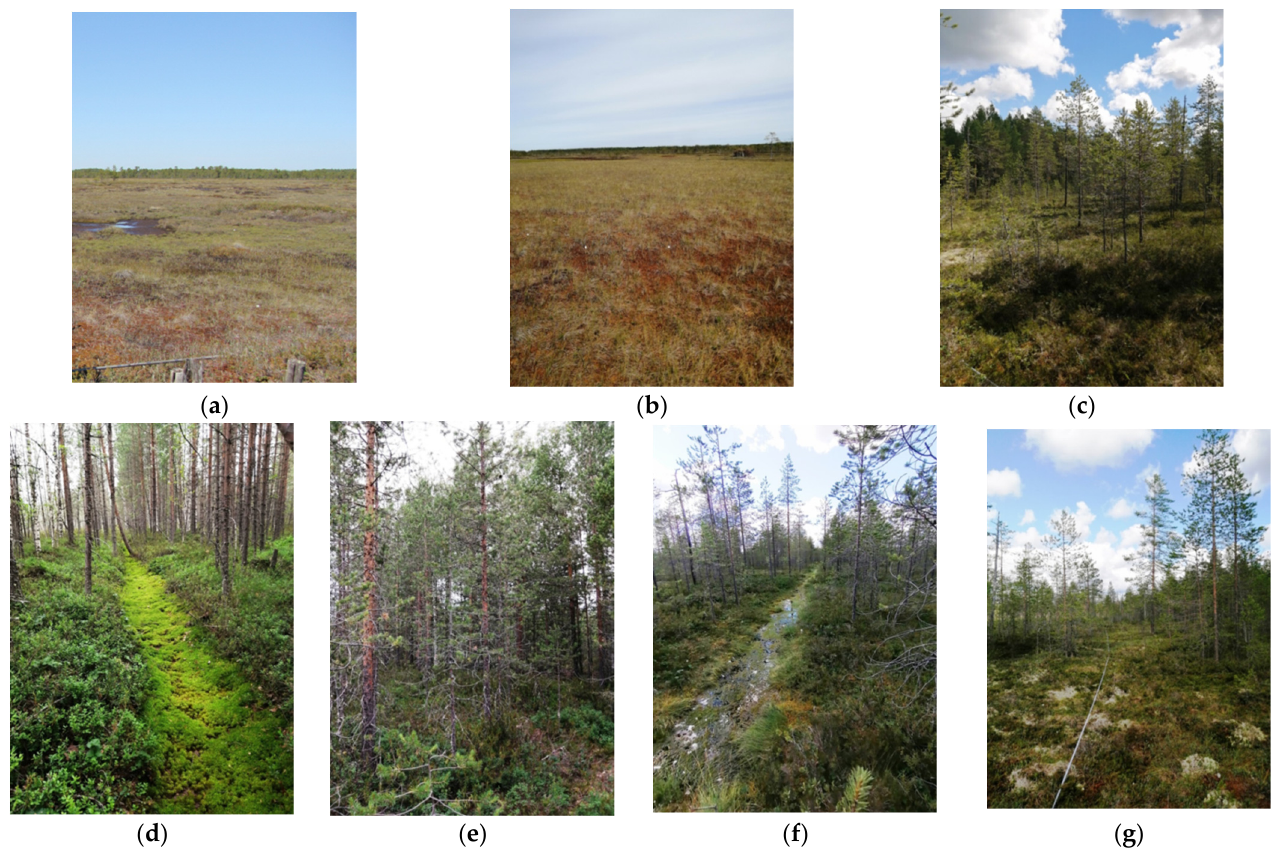
Figure 2. An overall view of the test sites: ( a ) UD-1; ( b ) UD-2; ( c ) UD-3; ( d ) D-1; ( e ) D-2; ( f ) RW-1; ( g ) RW-2.